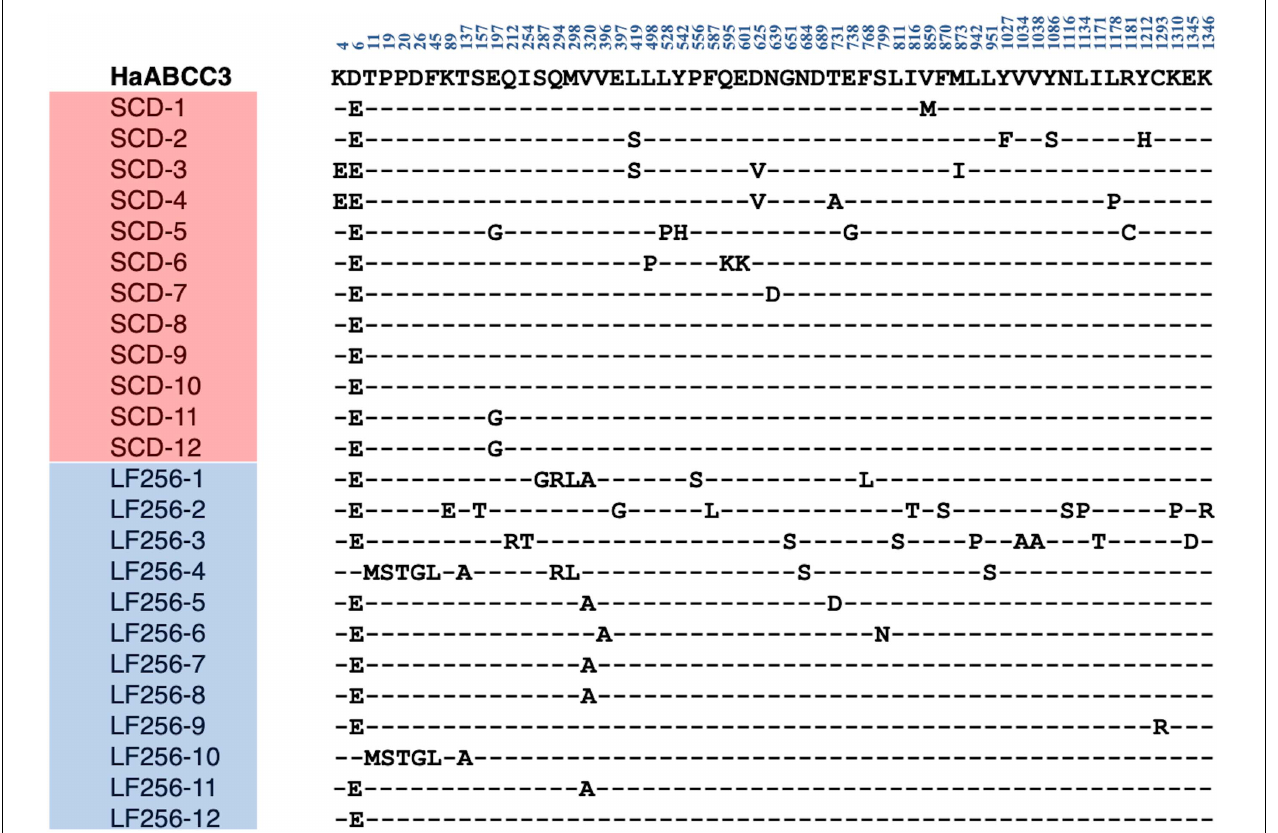
FIGURE 2 | Alignment of polymorphic amino acids predicted from sequencing cDNA of HaABCC3 from 12 larvae of susceptible strain SCD and 12 larvae of Cry1Ac-resistant strain LF256 of H. armigera. Dashes indicate the amino acids are the same as in the SCD GenBank sequence (MW592373, top line in bold).